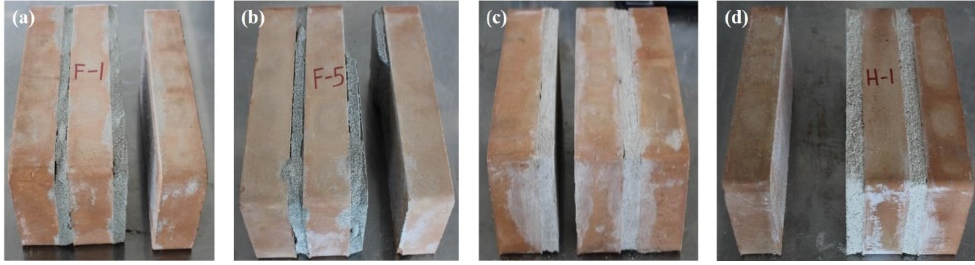
Figure 3. Observed triplet failure modes: ( a ) CB-LM 7/8; ( b ) CB-LM 1/8; ( c ) CB-GM 3/3; ( d ) CB-BM 3/3.